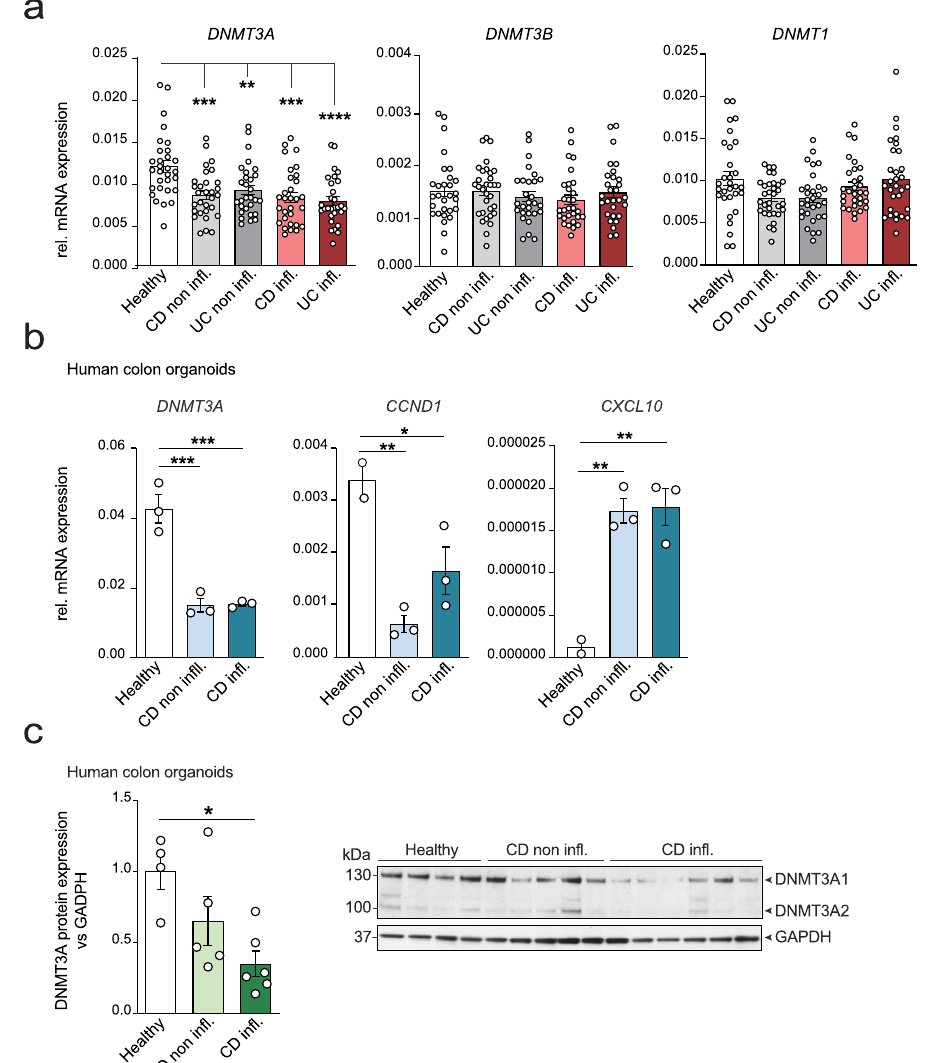
Fig. 1 | DNMT3A expression is downregulated in IBD patients. a Relative mRNA expression of DNMT3A , DNMT3B , and DNMT1 in biopsies from healthy controls ( n =30), CD non in fl amed (non in fl .) ( n =30), UC nonin fl amed (non in fl .) ( n =30), CD in fl amed (inf.) ( n =30), and UC in fl amed (inf.) ( n =30). Beta-actin was used as housekeeping gene. b Geneexpressionanalysisof DNMT3A , CCND1 ,and CXCL10 in humancolonicorganoidsderivedfromhealthycontrols( n =3),CDnonin fl .( n =3), and CD inf. ( n =3) patients. Beta-actin was used as housekeeping gene.